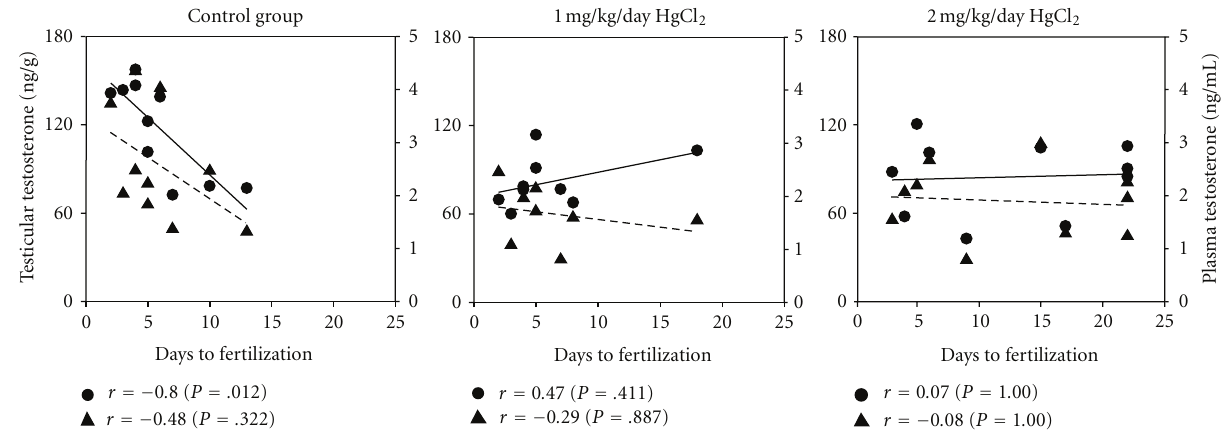
Figure 5: Correlation of testicular testosterone levels and plasma testosterone levels to days required to impregnate an unexposed female. (a) controls, (b) 1.0 mg/kg/day HgCl 2 , (c) 2.0mg/kg/day HgCl 2 . • Indicates testicular testosterone levels; (cid:2) indicates plasma testosterone levels.